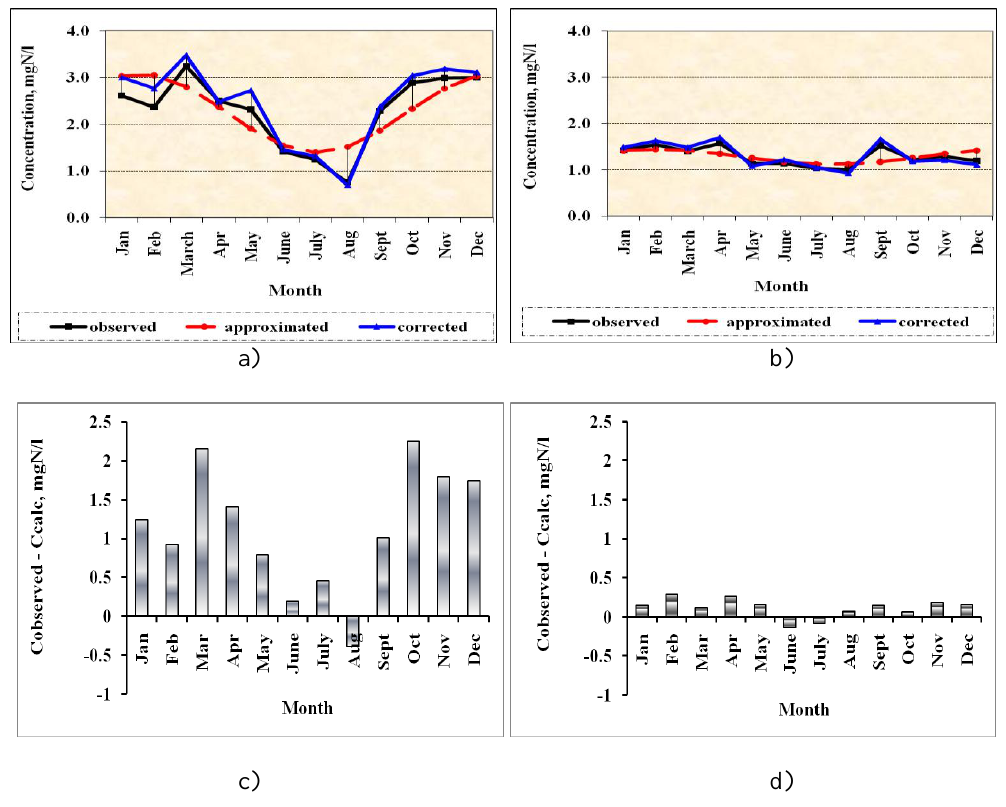
Figure 3. Intra-annual variations in monthly volume-weighted mean IFN concentrations (observed, corrected for variations in the rate of precipitation, and approximated by a Cosine function) in Sevastopol (a) and Katsiveli (b) ; the difference between the observed and calculated IFN concentrations in atmospheric depositions for individual months in Sevastopol (c) and in Katsiveli (d)